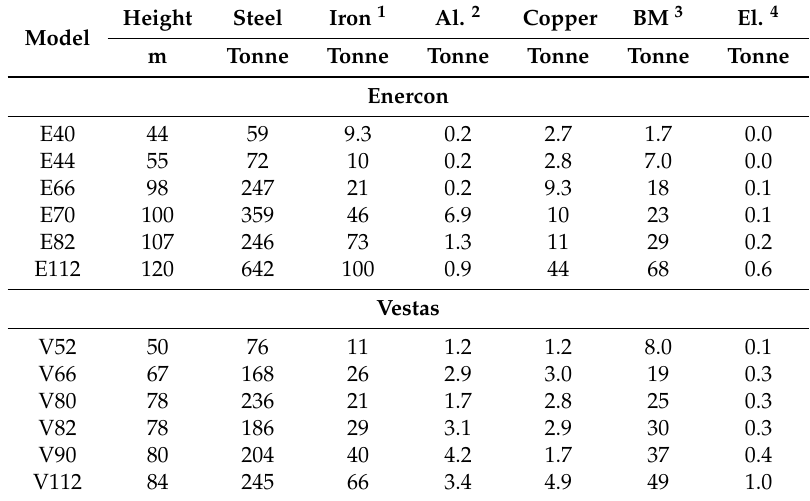
Table A1. Material amount for specific turbines common in Sweden collected from various life cycle assessments (LCAs) [44–49].